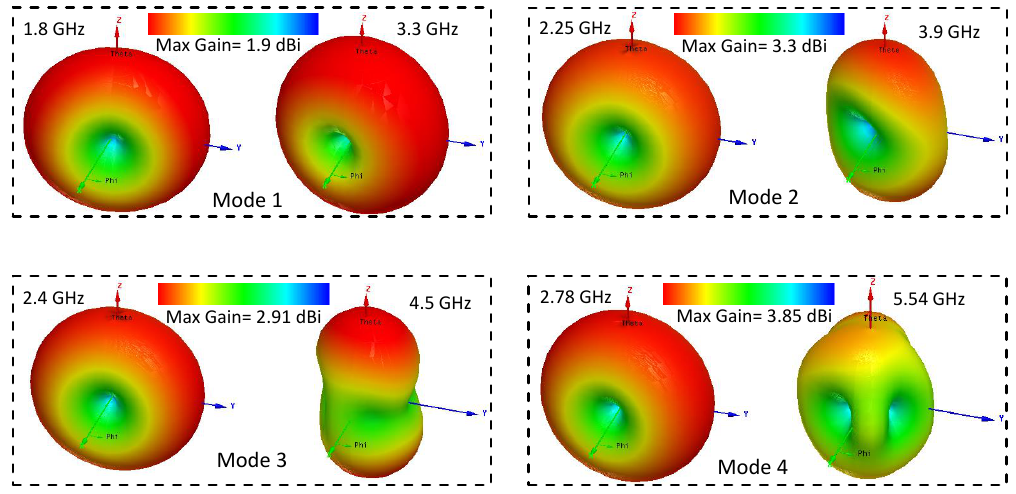
Figure 7. 3D pattern of the antenna for all operating